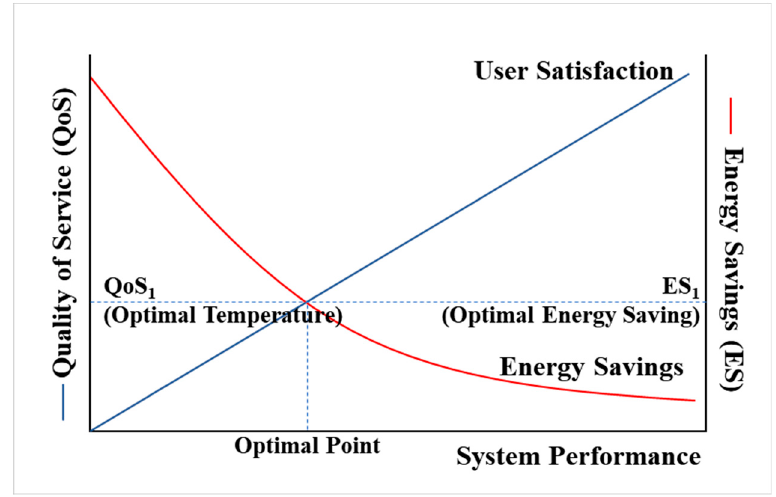
Figure 11. Relationship of QoS-ES-System Performance.